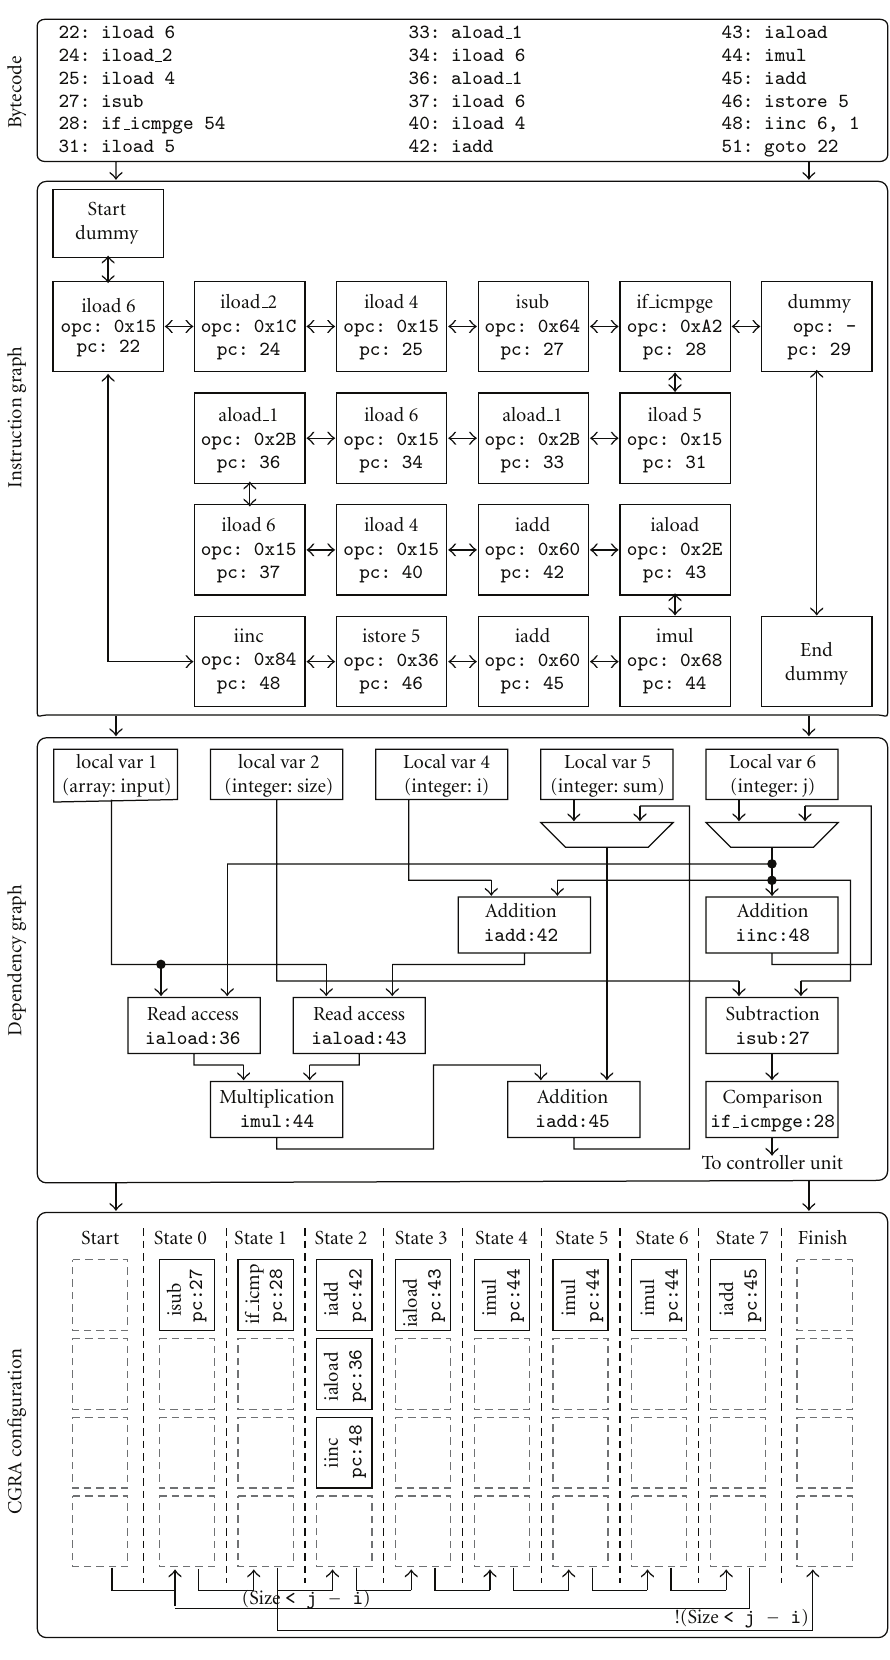
Figure 7: Example of intermediate synthesis